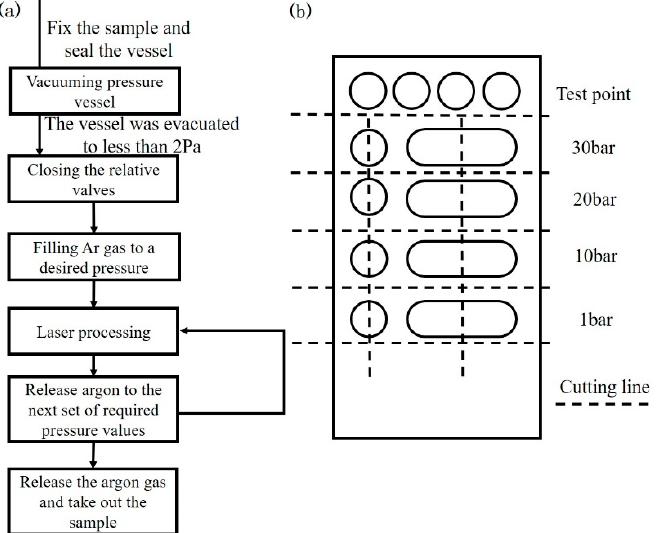
Figure 2. ( a ) Experimental procedure and ( b ) schematic of the laser processing scheme and param- eters.